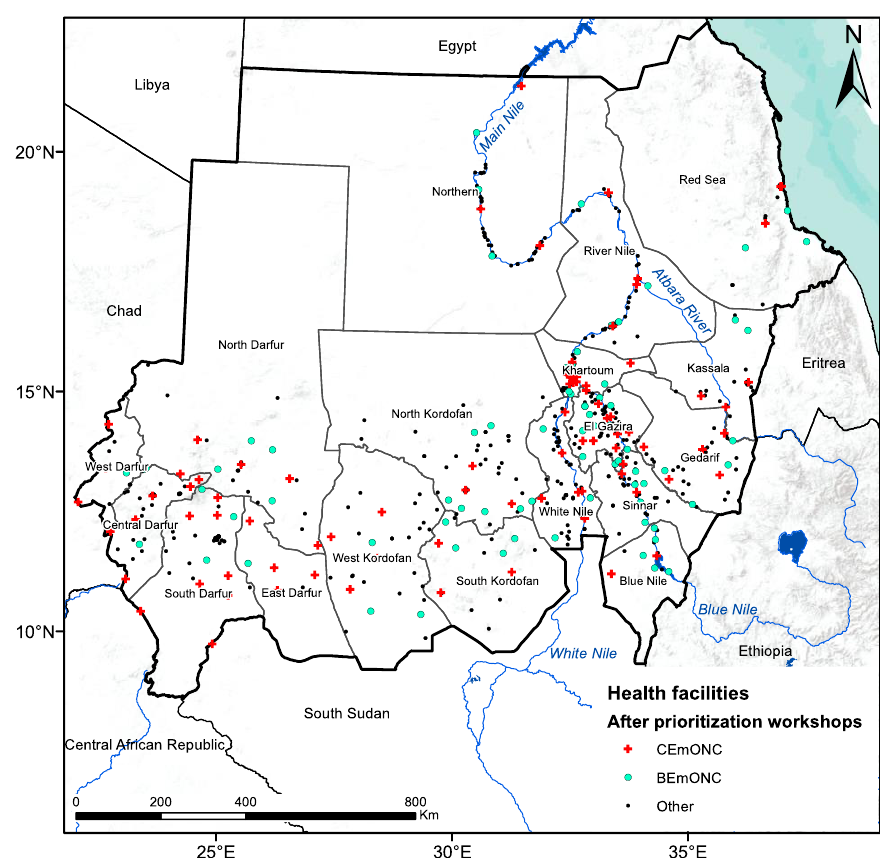
Figure 1. Map of Sudan, the 18 states, and the 631 health facilities that perform childbirth. CEmONC: Comprehensive emergency obstetric and newborn care; BEmONC: Basic emergency obstetric and newborn care.